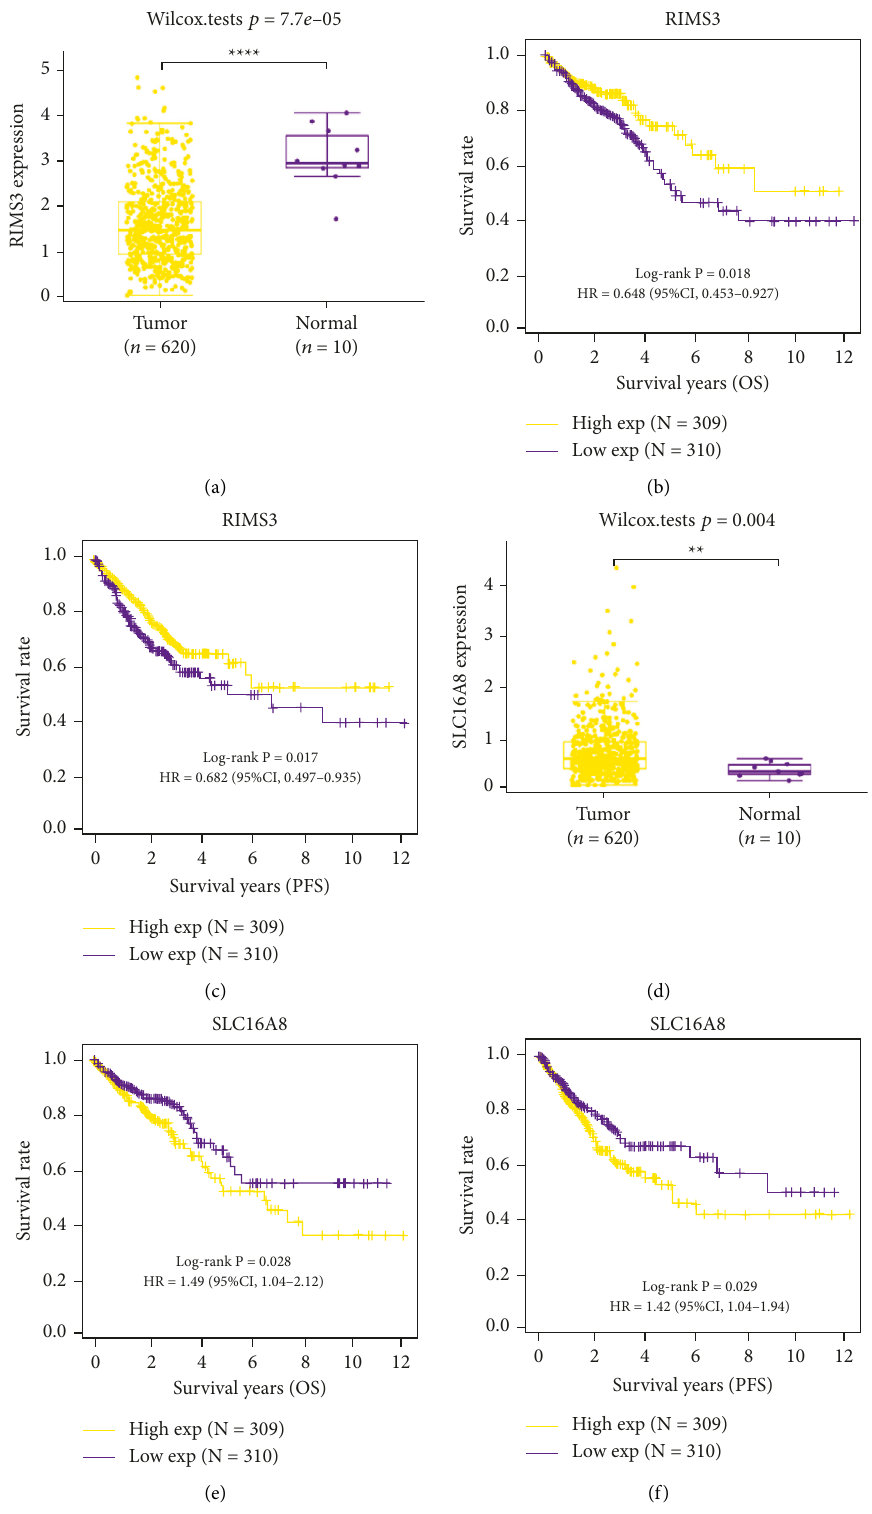
Figure 6: RIMS3 and SLC16A8 were the key mRNAs related to CRC in β -elemene treatment. (a) RIMS3 significantly downregulated in CRC samples. (b)-(c) The Kaplan–Meier survival curve showing that lower expression levels of RIMS3 were significantly associated with shorter OS and PFS in CRC. (d) SLC16A8 upregulated in tumor samples. (e)-(f) The Kaplan–Meier survival curve showing that higher expression levels of RIMS3 were significantly associated with shorter OS and PFS in CRC. ∗∗ P < 0 . 01, ∗∗∗∗ P < 0 .